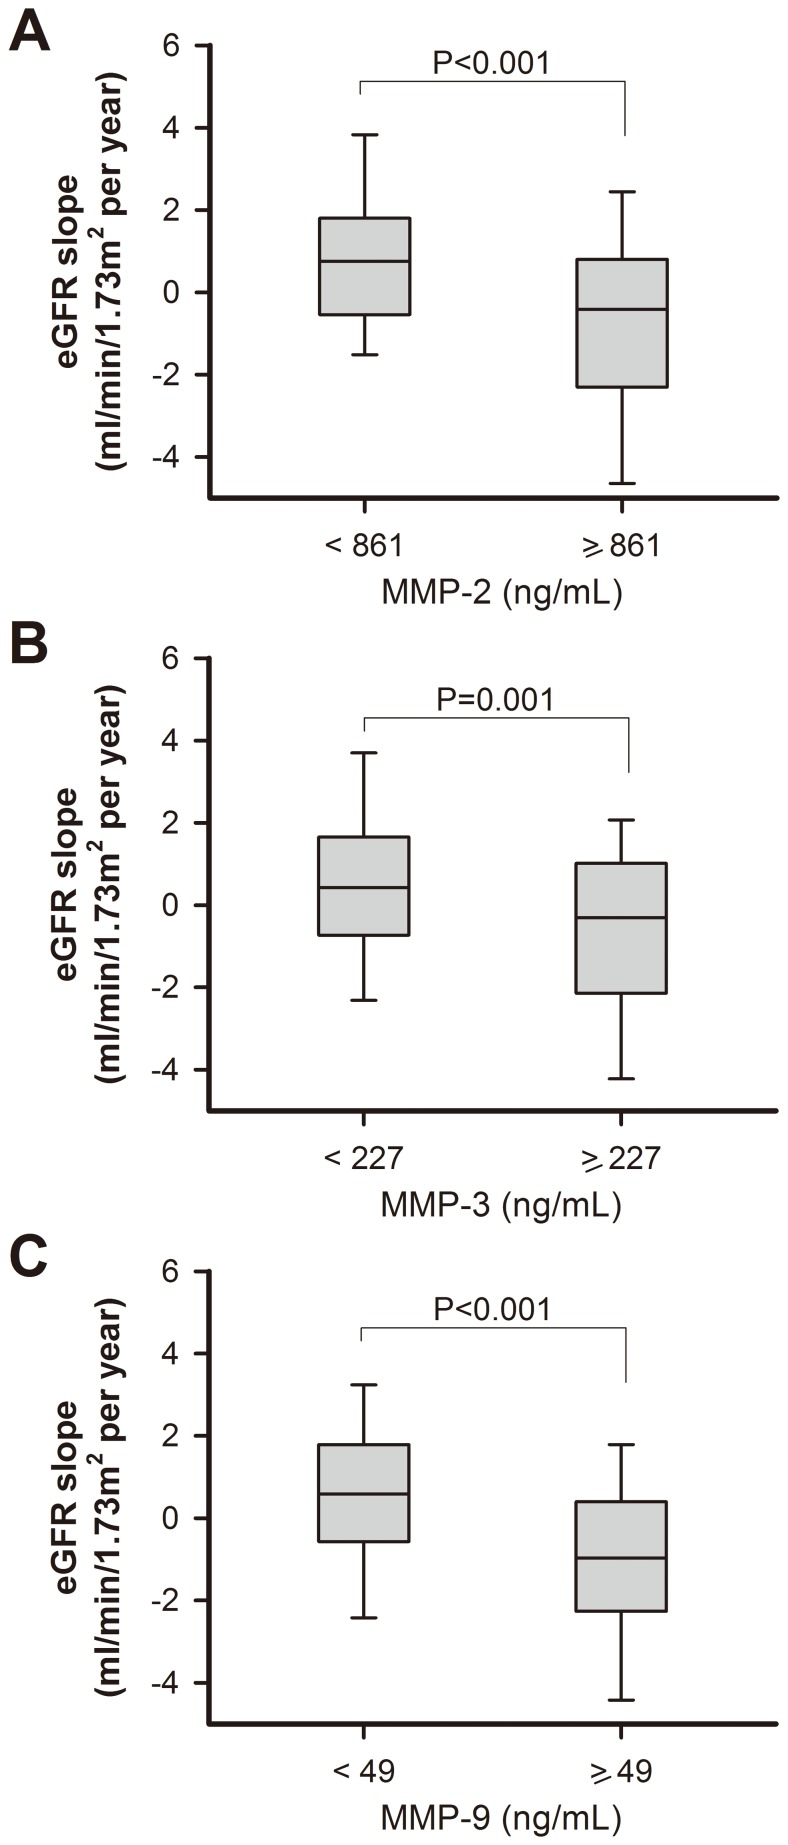
Whisker plots showing the 10th, 25th, 50th, 75th and 90th percentiles distribution of eGFR slope.Difference between patients with MMP-2 (A), MMP-3 (B) and MMP-9 (C) above and below the medians, respectively. Medians of baseline plasma MMP-2, MMP-3 and MMP-9 levels were 861 ng/mL, 227 ng/mL, and 49 ng/mL, respectively. Abbreviations: eGFR, estimated glomerular filtration rate; MMP, matrix metalloproteinase.